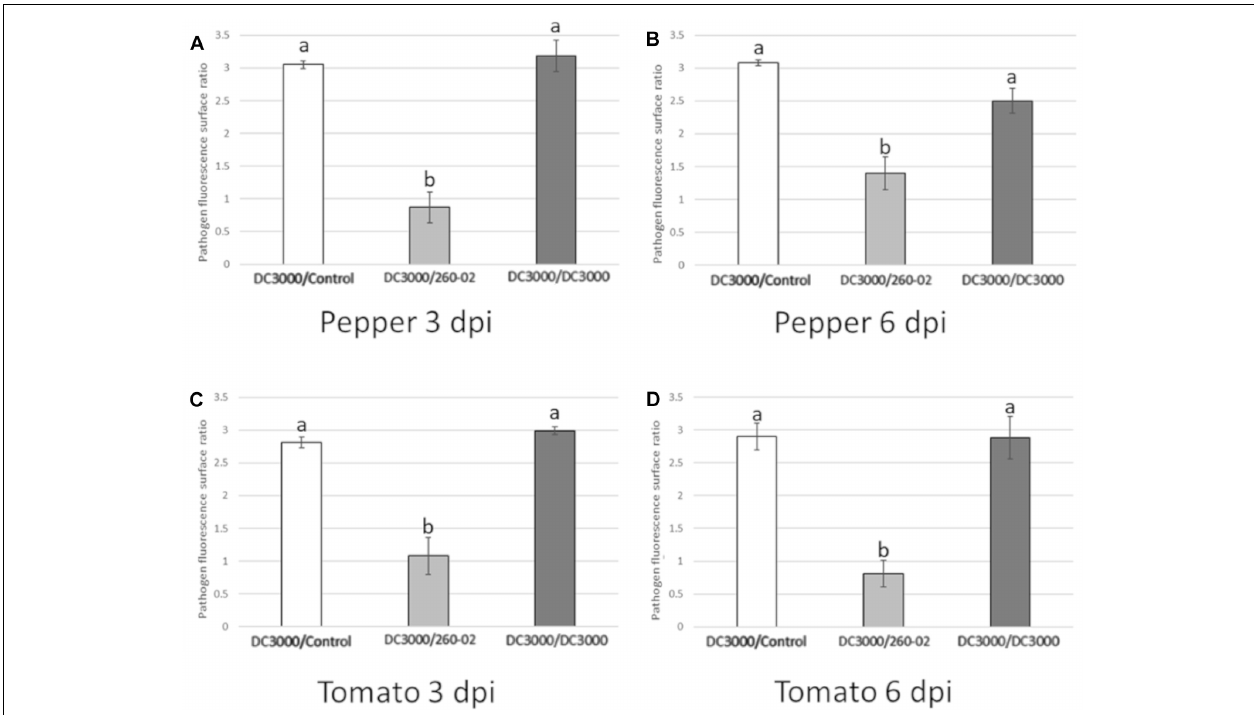
FIGURE 9 | Charts reporting the results of the quantitative analyses of confocal microscopy pictures taken from the abaxial surface of leaves infected by DC3000:: gfp ( Figure 7 ) either with PBS root treatment (DC3000/Control, in white), with 260-02 root treatment (DC3000/260-02, in light gray), or with DC3000 root treatment (DC3000/DC3000, in dark gray). On the vertical axis is the amount of leaf surface, expressed as a base 10 logarithm of µ m 2 , on which GFP fluorescence from the bacteria was visible. Error bars indicate standard deviation. Bars represent the average value obtained by analyzing 7 images per treatment. Letters (a,b) indicate significantly different results according to One-Way ANOVA test, followed by Tukey’s Exact post hoc ( p < 0.05). Graphs (A,B) indicate results obtained in pepper plants at 3 and 6 dpi, respectively. Graphs (C,D) indicate results obtained in tomato plants at 3 and 6 dpi,